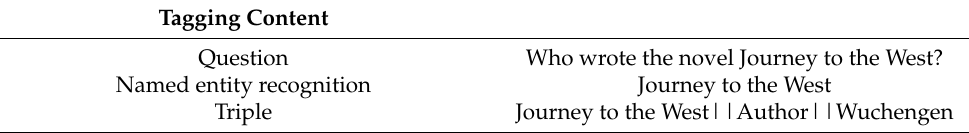
Table 2. Dataset sample annotation sample.